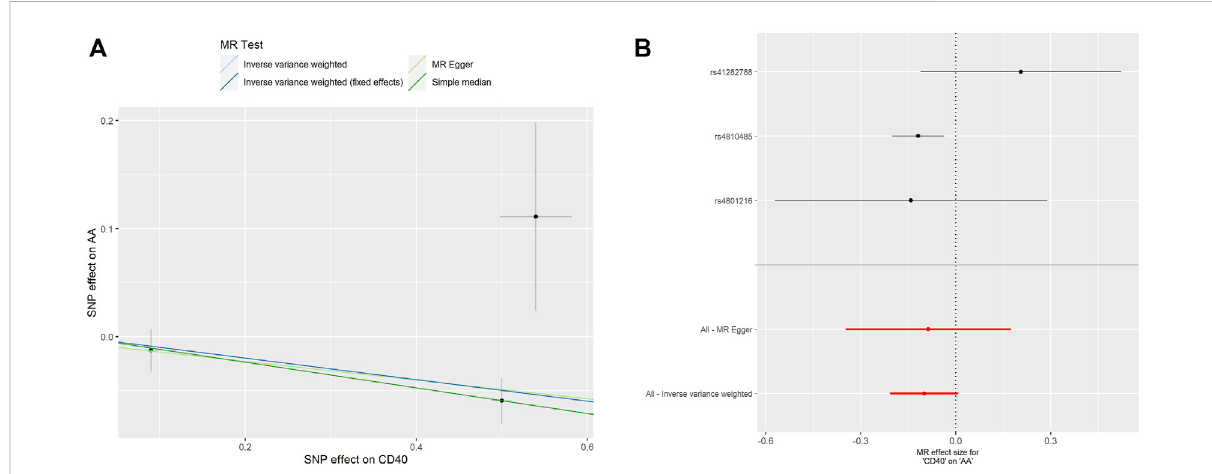
FIGURE 3 MR analyses of genetic proxied CD40 levels on the risk of AA. The scatterplot (A) and the forest plot (B) of the MR analysis of CD40 and AA. AA, aortic aneurysm; MR, Mendelian